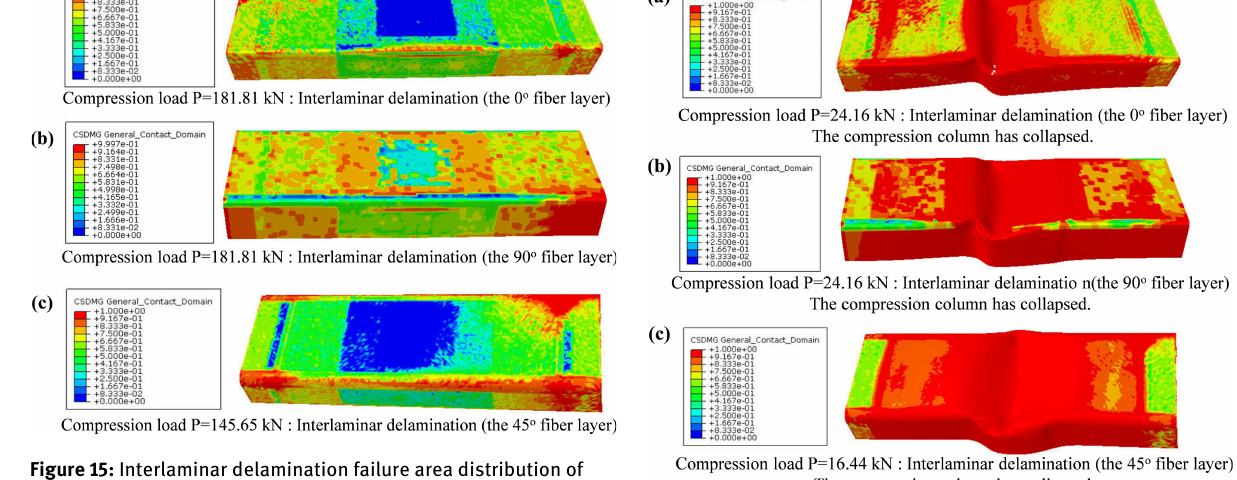
Figure 15: Interlaminar delamination failure area distribution of compression columns at 300 MPa: (a) DCYG-A: 0 ∘ fiber layer, (b) DCYG-A: 90 ∘ fiber layer, and (c) DCYG-B: 45 ∘ fiber layer.